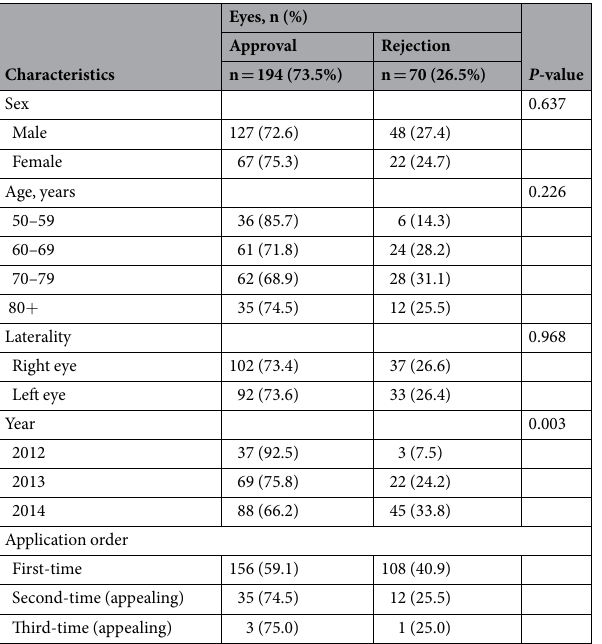
Table 1. Demographics and characteristics of 264 eyes (229 patients) with neovascular age-related macular degeneration in a university medical centre in 2012–2014 for which an application was made to the national health insurance system in Taiwan for funding of treatment with